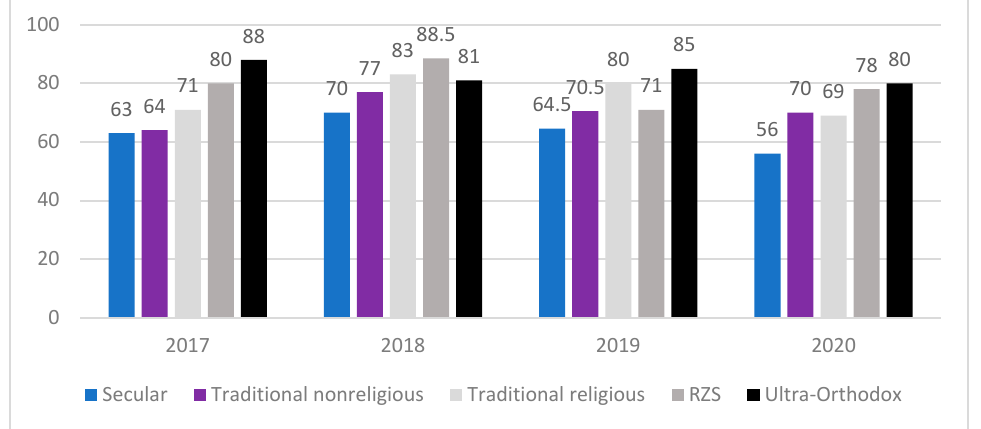
Figure 8. Agree that the Israeli regime is democratic for its Arab citizens, by level of religiosity, 2017 ‒ 2020 (%) (Source: Israeli Democracy Index, 2017 ‒